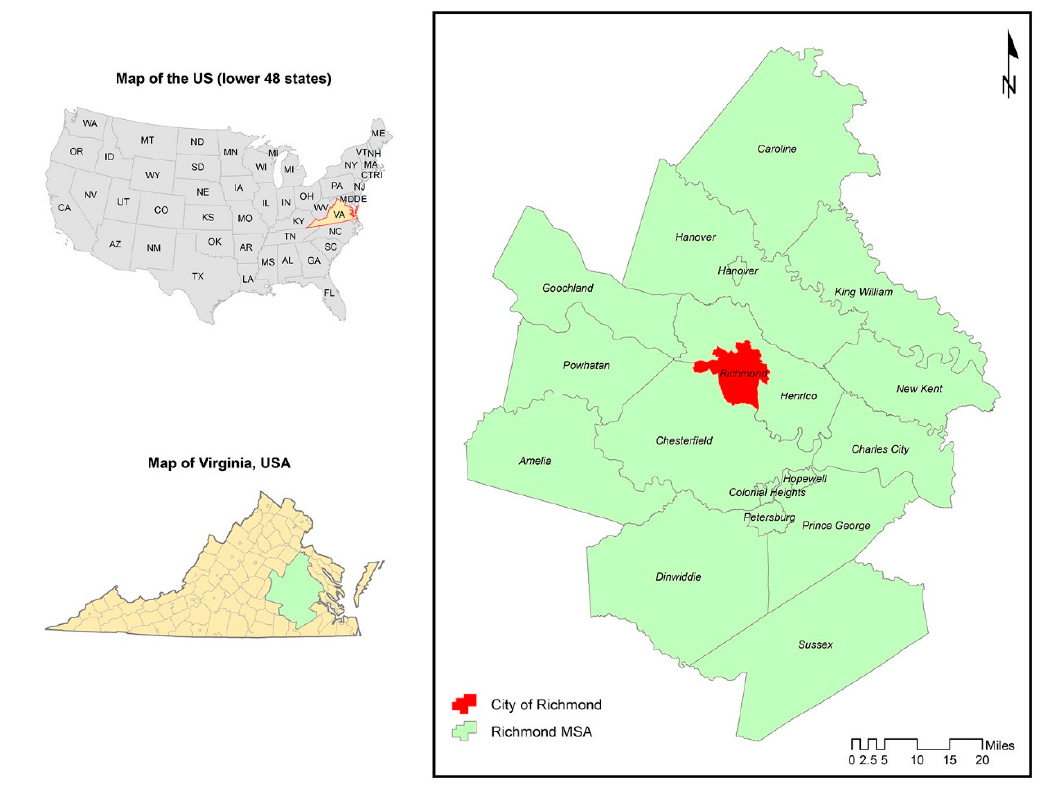
Figure 2. Study area location—City of Richmond, Virginia.